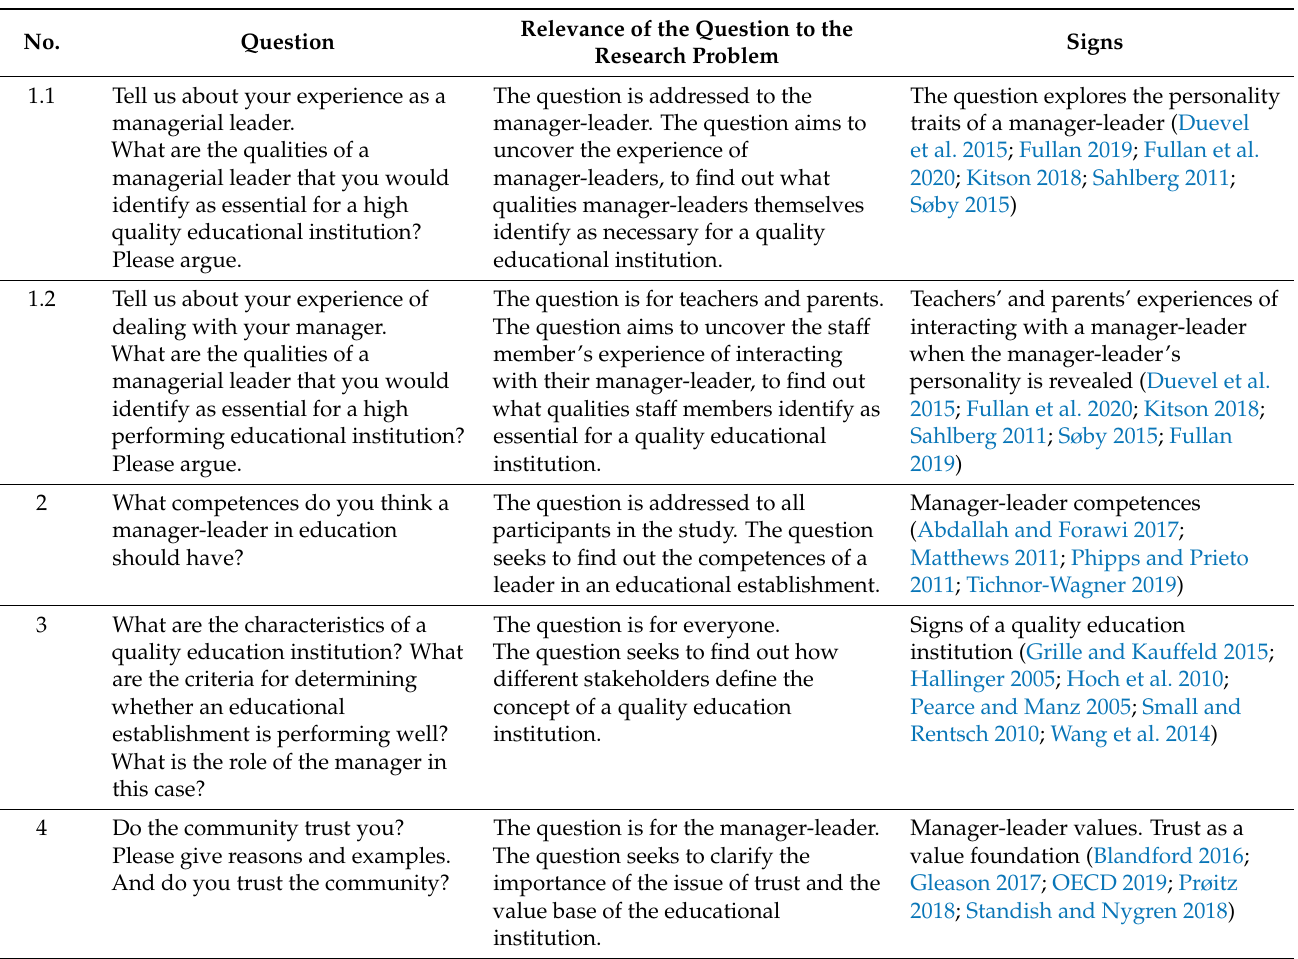
Table 1. Semi-structured interview questions exploring the attributes of a managerial leader and their expression in an educational institution and their